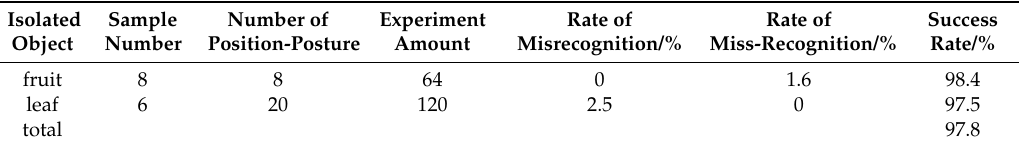
Figure 16. Objects with corresponding intersection curves in an isolated area: ( a ) isolated fruit; ( b ) isolated leaf. Table 4. Recognition rate of an isolated